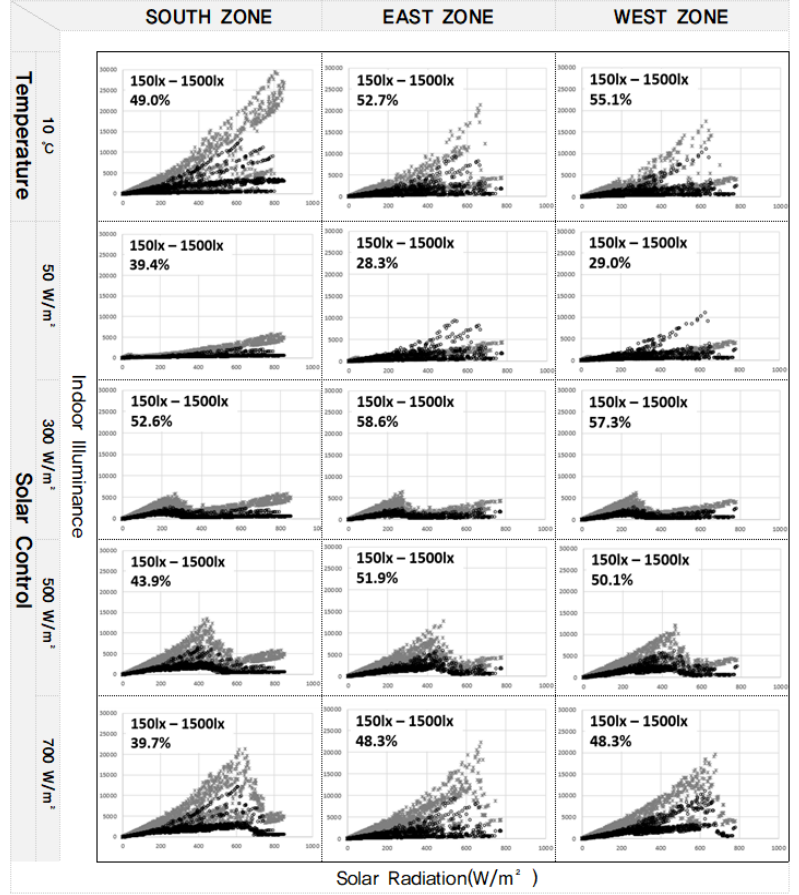
Figure 16. Analysis result of proper indoor illuminance over a year by control conditions of electrochromic glass.